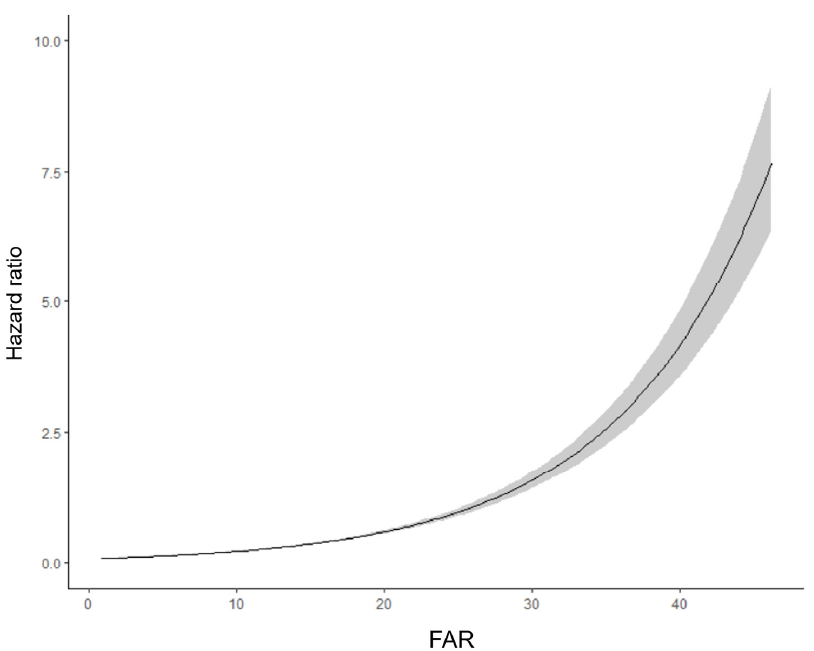
Figure 1. Estimated risk of one-year mortality according to fibrinogen/albumin ratio (FAR) upon intensive care unit admission.